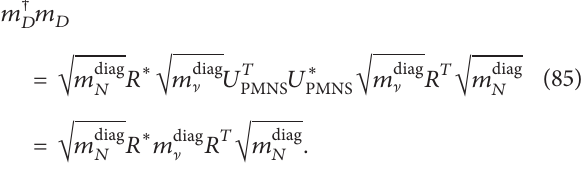
̂Δ𝑀 Σ𝑚 Figure 6: ℎ (blue) and ] 𝑖 (purple) as a function of the lightest for a normal hierarchy (solid) and 𝑚 ] neutrino mass, 𝑚 ] 1 inverted hierarchy (dashed). The rest of the model parameters are set as in